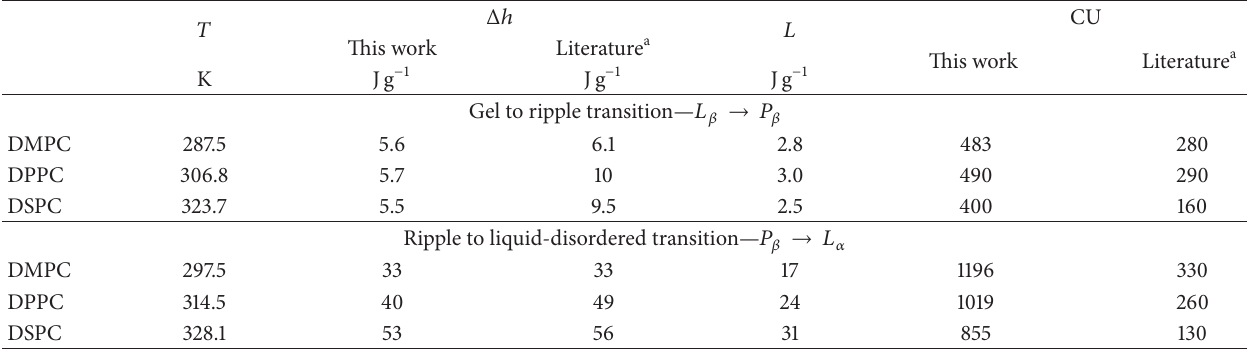
CU This work Literature a